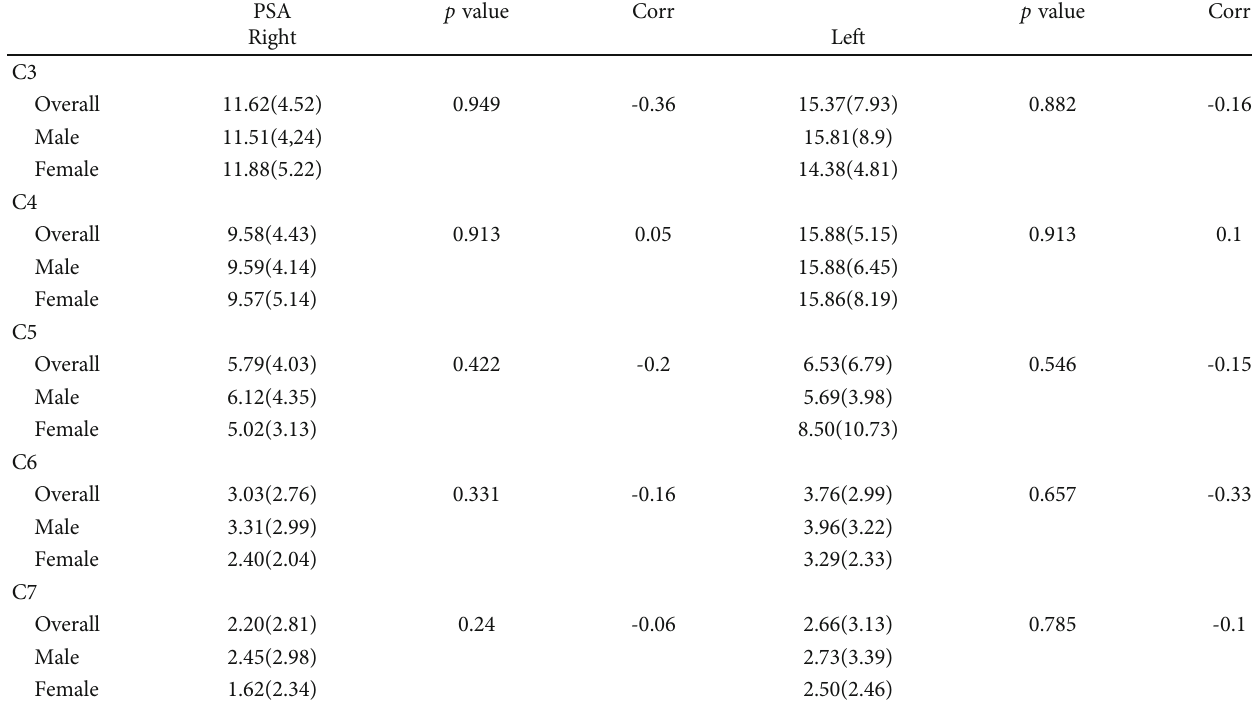
Table 5: Pedicle sagittal cervical angles of pedicles of 70